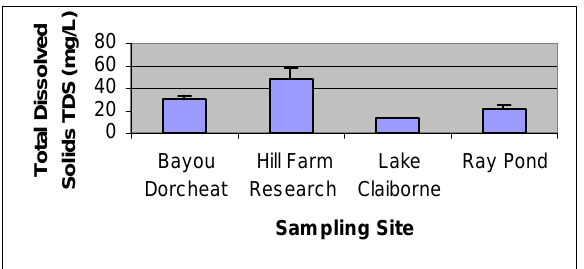
Figure 4: Mean values of total dissolved solids TDS (mg/L) at each of the sampling sites. Differences in mean levels at sampling sites are highly significant (p<0.001), n=15.